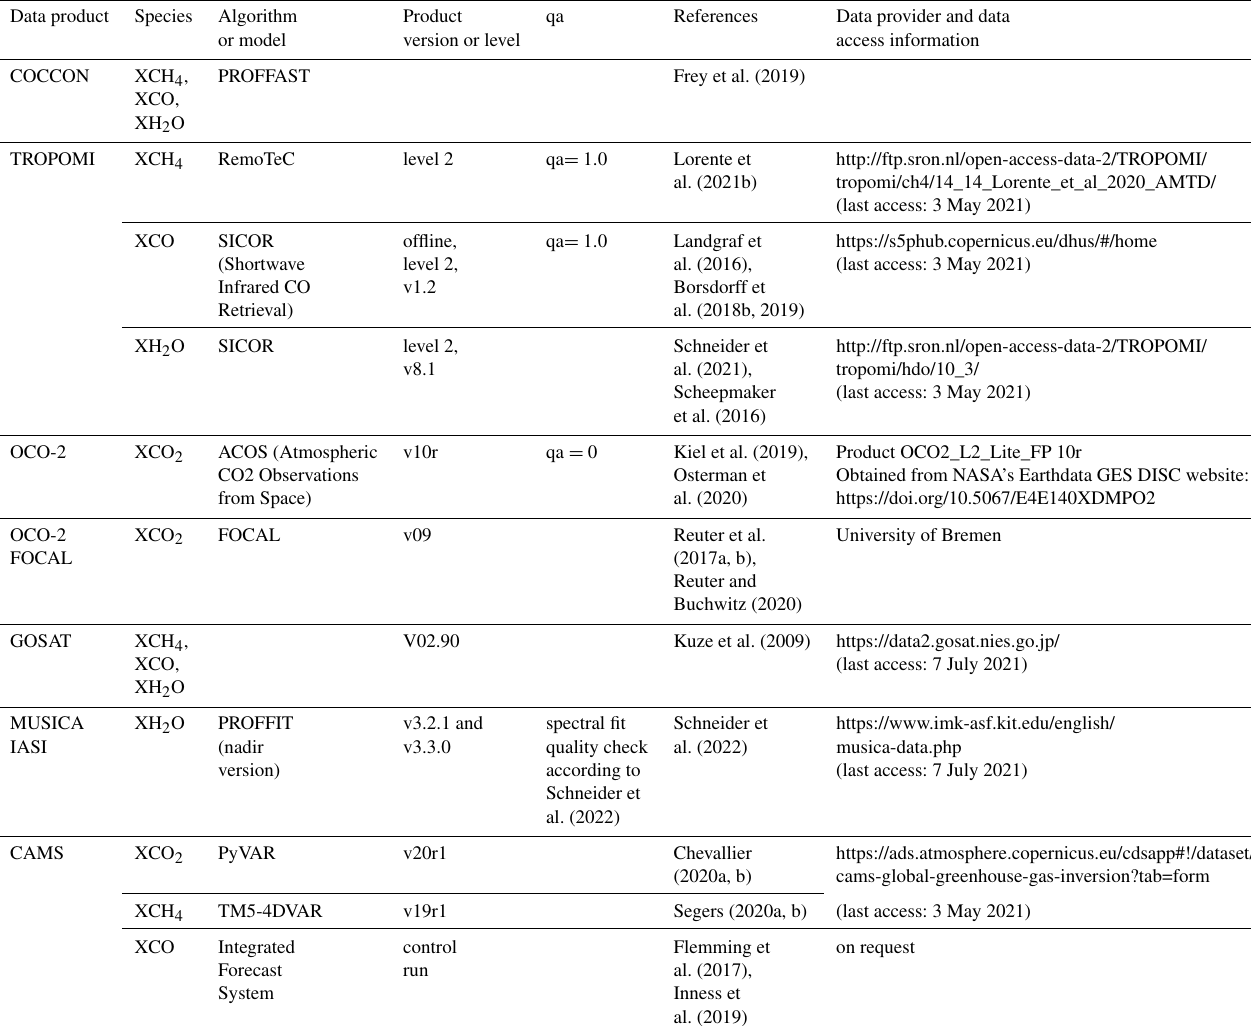
Table A1. Overview of the satellite and model data products used in this study.